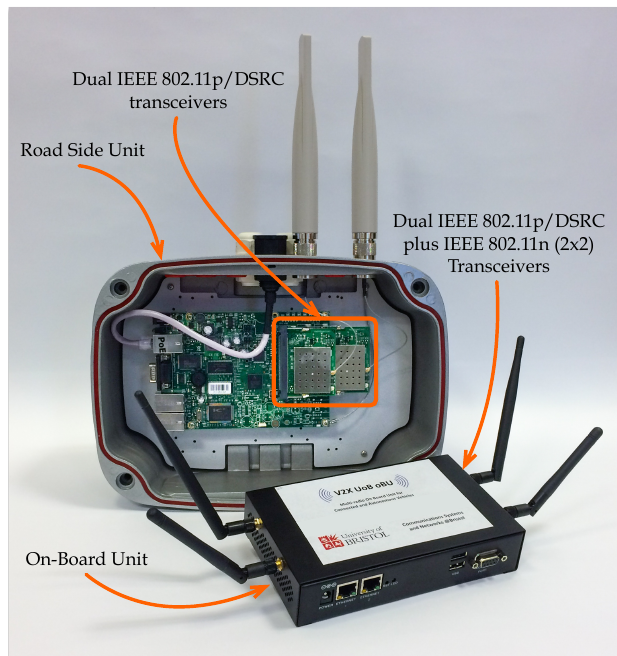
Figure 2. Low-latency Linux Kernel implementation of IEEE 802.11p/DSRC units prototyped by the University of Bristol. The figure shows units designed for a road side and an on-board vehicle